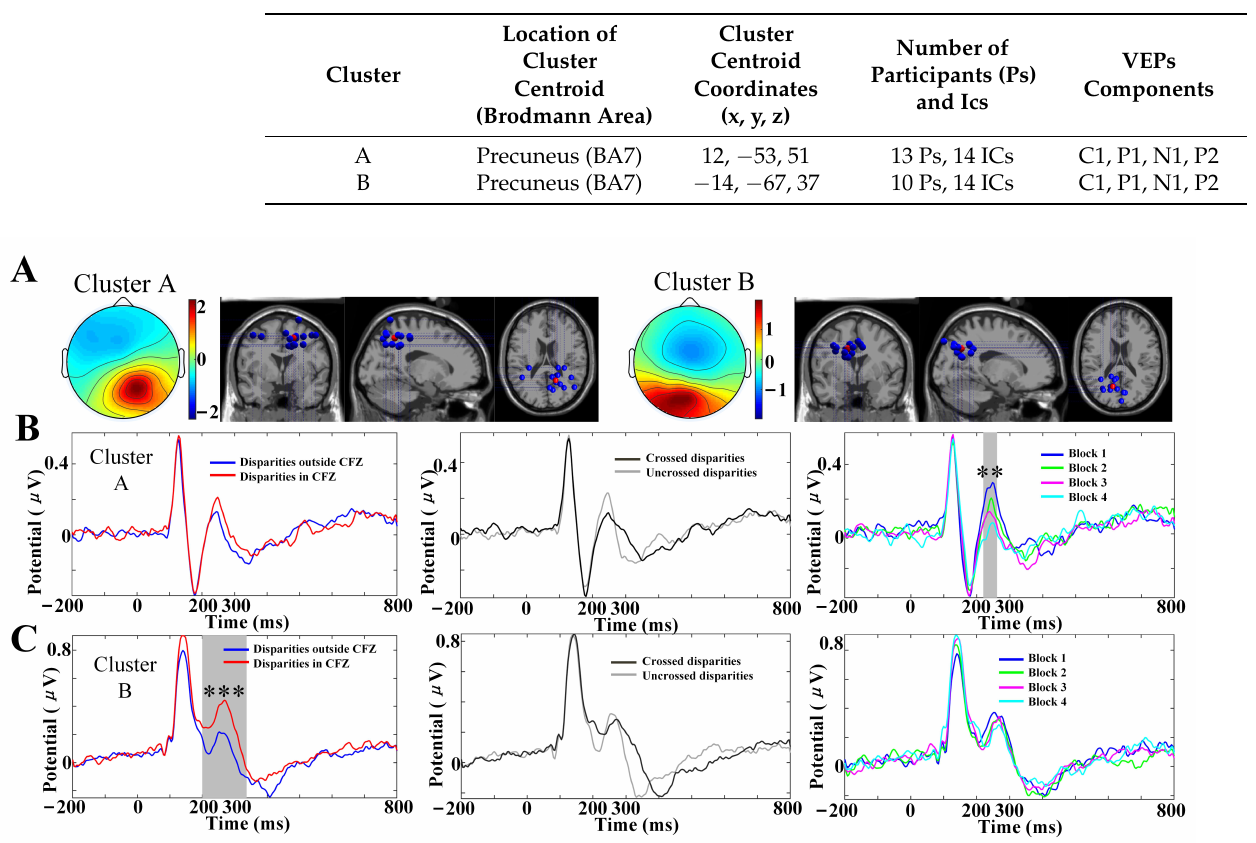
Figure 6. ( A ) Scalp maps and dipole locations of IC clusters contained component P2. Each cluster is visualized in the MNI brain volume in coronal, sagittal, and top views. Blue-colored spheres indicate the dipole locations for single cortical sources for single participants, and red-colored spheres indicate cluster centroids. ( B ) VEPs comparison results of cluster A. ( C ) VEPs comparison results of cluster B. The grey underlining denotes time region of peak amplitude significant differences after the cluster method corrected, *** p < 0.001, ** p <